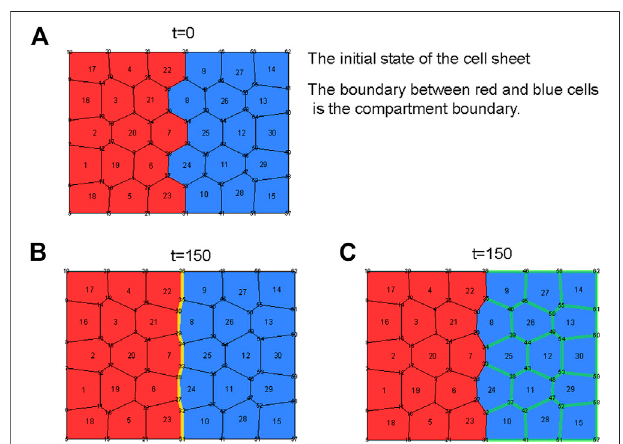
FIGURE 1 | (A) The initial state of the cell sheet. Red and blue cells are anterior and posterior cells, respectively. At the initial state of the sheet, both cells have the same parameters.Attime t (cid:1) 0, someparametersare changed. Thecompartmentboundaryistheboundarybetweenred andbluecells. (B) The fi nal state of the cell sheet when c ij at the compartment boundary is changed from c ij (cid:1) 0 . 1(default value) to c ij (cid:1) 0 . 2 (see Supplementary Movie 1 ). (C) The fi nal state of the cell sheet when τ PP at the cell boundary between P cells is changed from τ PP (cid:1) 0 . 1 (default value) to τ PP (cid:1) 0 . 3 (see Supplementary Movie 2 ). To highlight which cell boundary changed parameters, we colored them yellow (B) and green (C) . The parameter values used here are K (cid:1) 4, k (cid:1) 1, A ( 0 ) α (cid:1) 2 . 2, c ij (cid:1) 0 . 1 (default), k pm (cid:1) 5, η (cid:1) 0 . 01, (cid:12)(cid:12)(cid:12)(cid:12)(cid:12)(cid:12) (cid:13) τ (cid:1) 0 . 1 (default), and L ( 0 ) (cid:1) 1 . 2 × ( 2 π ) (cid:1) 6 . 3. For the units of these A ( 0 ) α / π α ij parameters see Supplementary Table 1